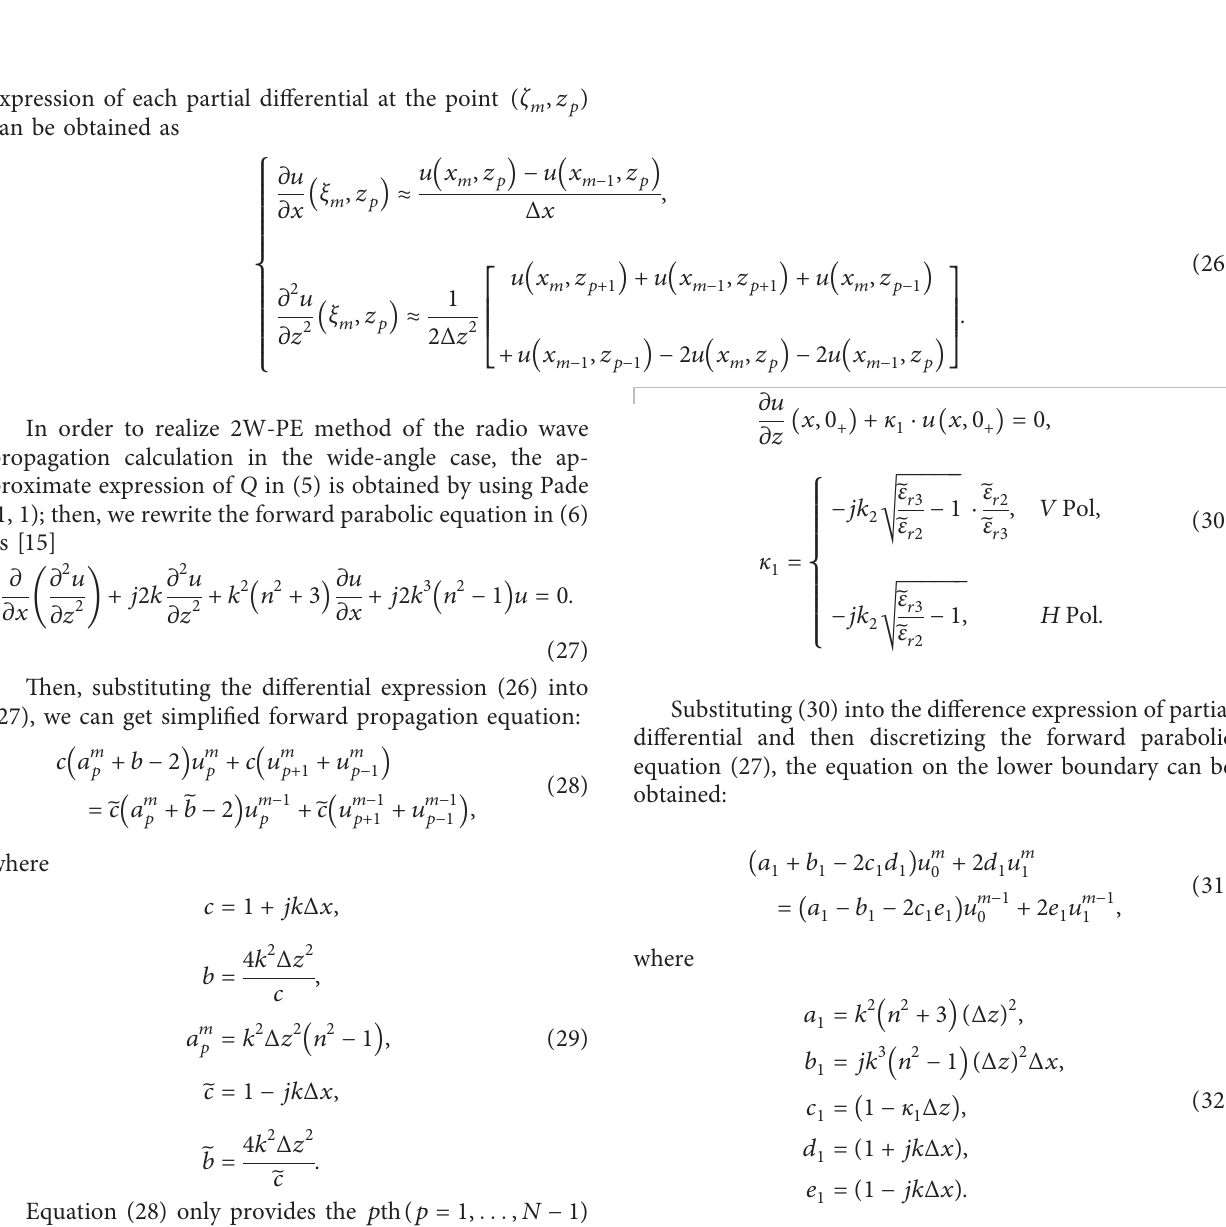
Figure 4: Schematic diagram of finite difference mesh